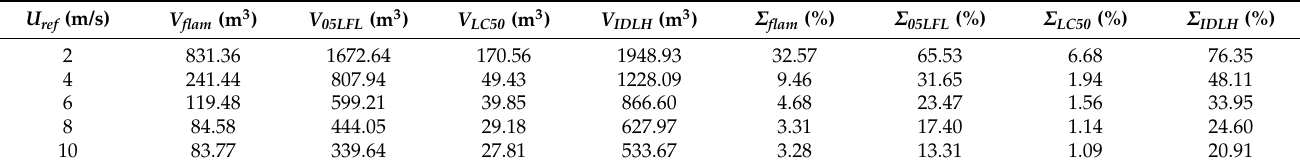
Figure 14. IDLH volume for U ref = 10 m/s. The emitting cube is shown in black. This comparison confirms the previous considerations about the 2D distributions on the platform section at a height of 1.5 m. Despite the fact that only the U ref = 10 m/s case is shown, the difference in the two volumes is representative of all the other cases, no matter if the wind influence is less relevant. To better analyze the scenarios, Table 4 shows some useful parameters, including the flammable volume V flam , the volume related to 0.5LFL V 05LFL , the toxic volume related to LC 50 V LC50 , the toxic volume related to IDLH V IDLH , and their percentage ratios with respect to the total domain volume, including Σ flam , Σ 05LFL , Σ IDLH and Σ LC50 , respectively. Table 4. Risk-oriented quantities obtained in the 5 dispersion simulations. U ref (m/s)